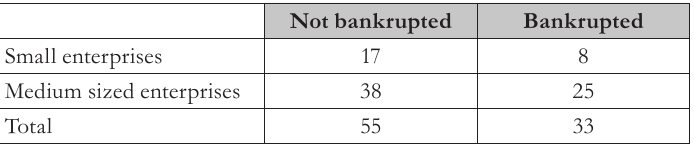
Tab. 1 – Figures of the initial per company type and bankruptcy situation. Source: own construc-